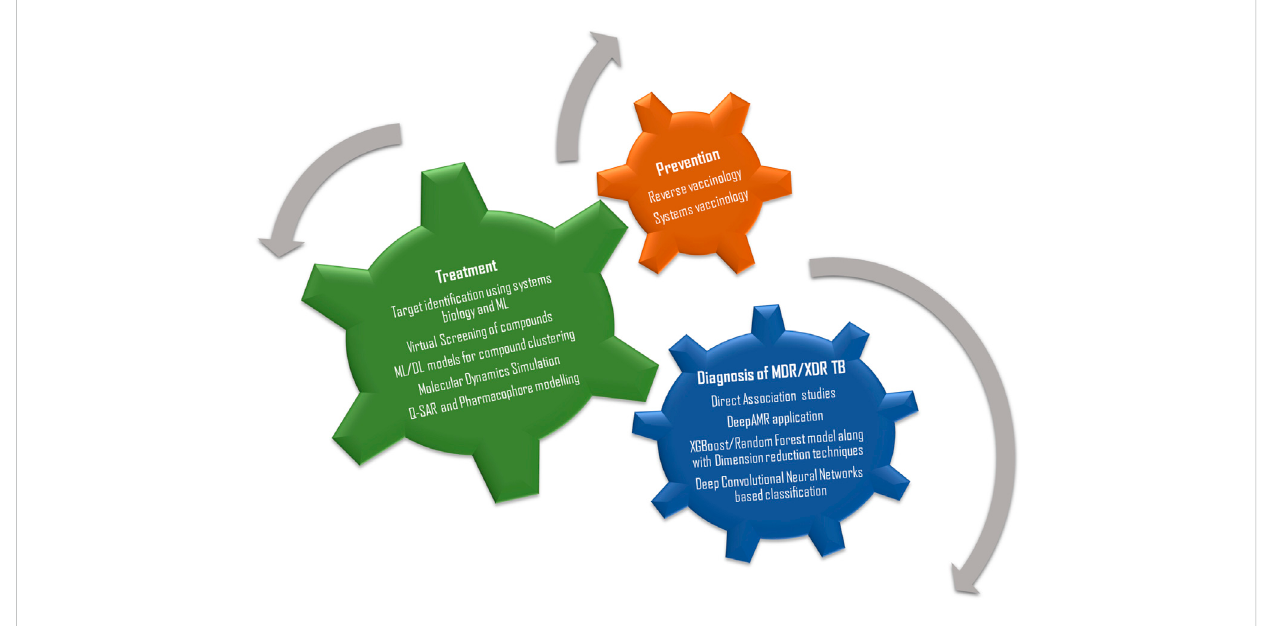
FIGURE 1 The three wheels of research and development essential for TB